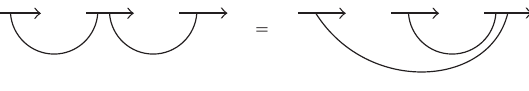
Figure 7.5 . A 2-term